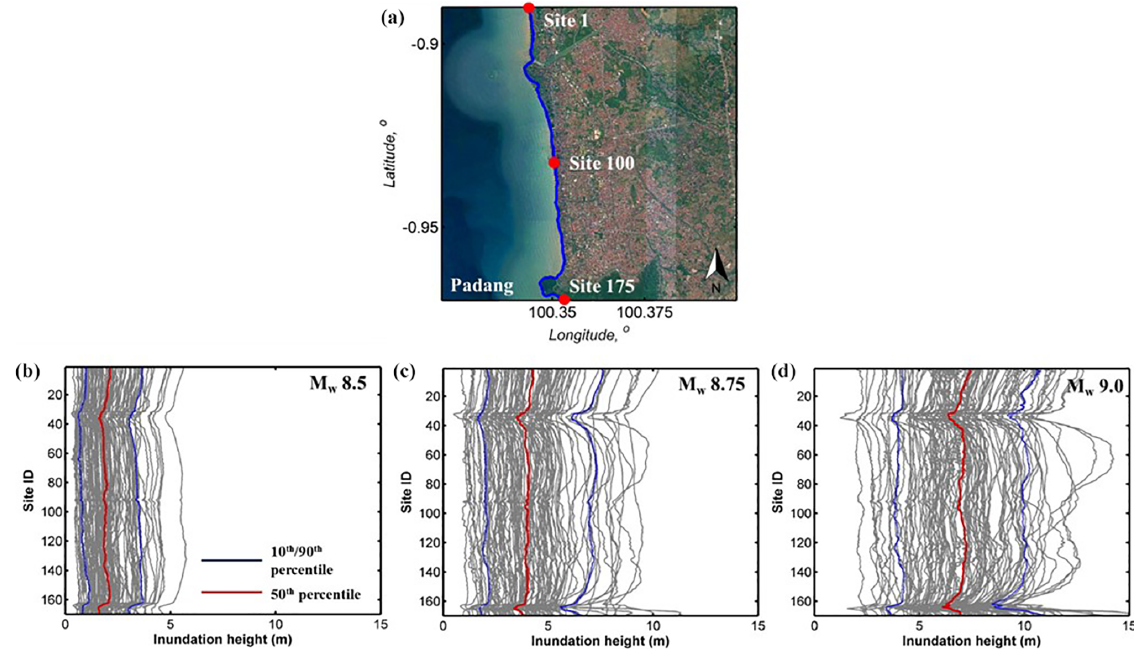
Figure 10. (a) Site location. (b) Maximum tsunami inundation height in the coastal line of Padang for the M w 8.5 scenario. (c) Maximum tsunami inundation height in the coastal line of Padang for the M w 8.75 scenario. (d) Maximum tsunami inundation height in the coastal line of Padang for the M w 9.0 scenario.